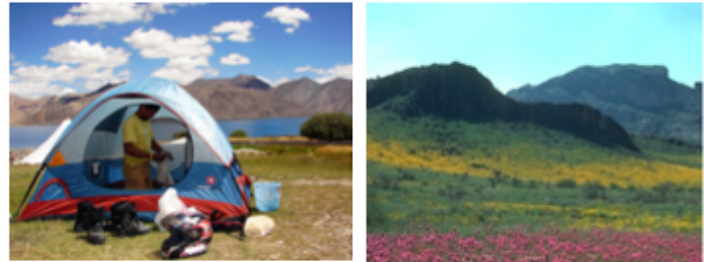
Figure 4. Examples from SUN Attribute (SUN)